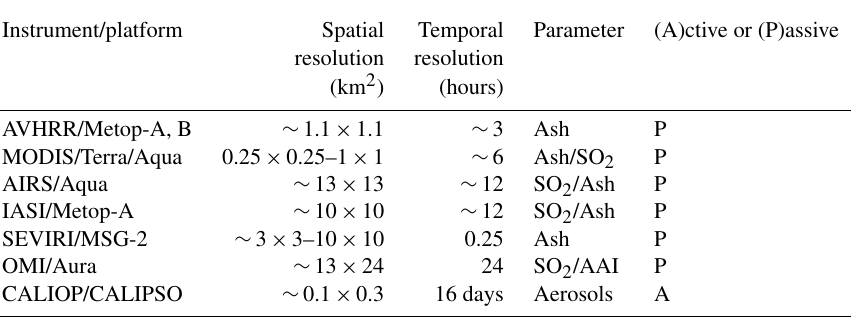
Table 1. Satellite instruments used in this study to identify volcanic emissions. The instruments are AVHRR: advanced very high resolution radiometer, MODIS: Moderate Resolution Infrared Spectroradiometer, AIRS: Atmospheric Infrared Sounder, IASI: infrared atmospheric spectroradiometer interferometer, SEVIRI: Spin-stabilised Enhanced Visible and Infra-Red Instrument, OMI: Ozone Monitoring Instrument, and CALIOP: Cloud-Aerosol Lidar with Orthogonal